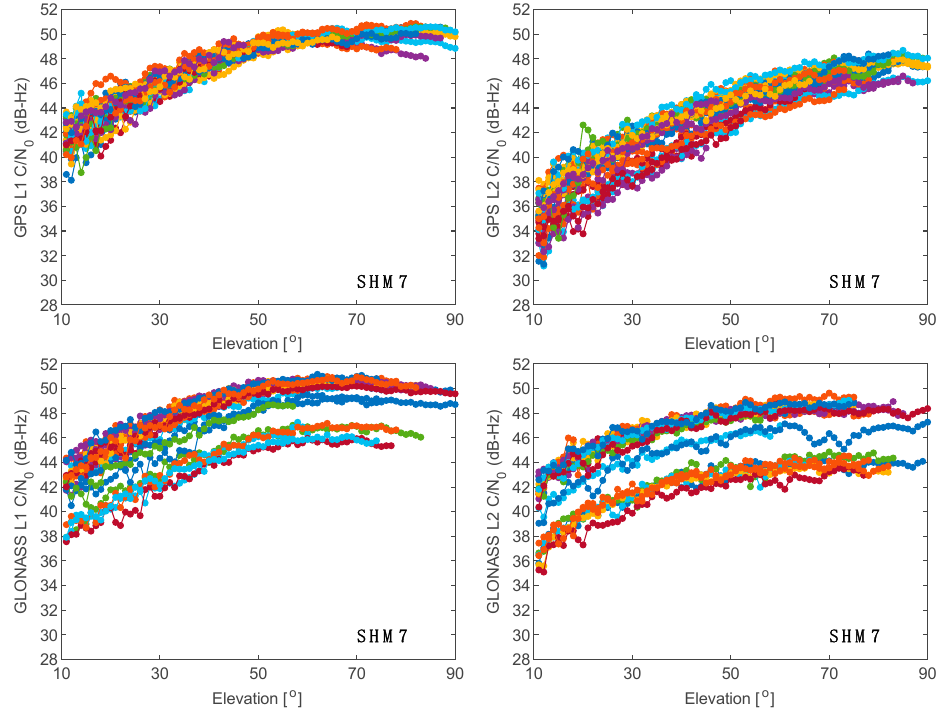
Figure 6. GPS and GLONASS SNR average value within one elevation versus elevations at site SHM7.